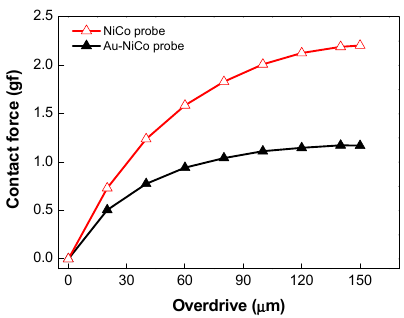
Figure 9. Variation in contact forces with increasing overdrive when the probe contacted the Cu pillar microbump.